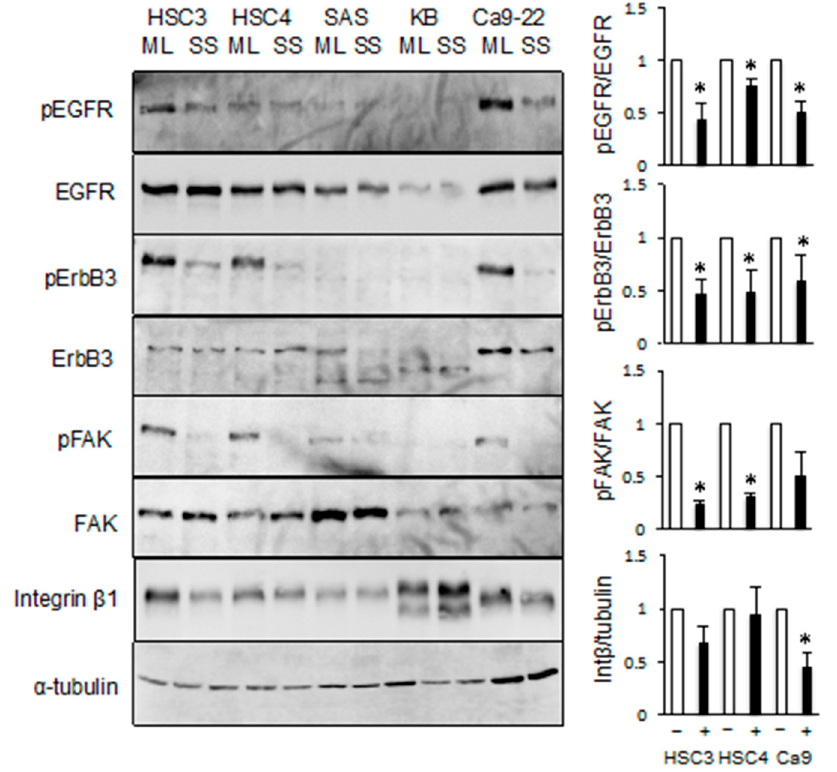
Figure 6. The phosphorylation levels of focal adhesion kinase (FAK), EGFR, and ErbB3 were reduced in suspension cultures. HSC3, HSC4, SAS, KB, and Ca9-22 cells were cultured on ultra-low adhesion plates (suspension; SS) or tissue culture plates (monolayer; ML). The levels of phosphorylated EGFR, ErbB3, FAK, and integrin β 1 were determined by western blotting analysis. α -tubulin was used as the loading control. * Significantly different from control, p < 0.05. Experiments were performed three times independently.